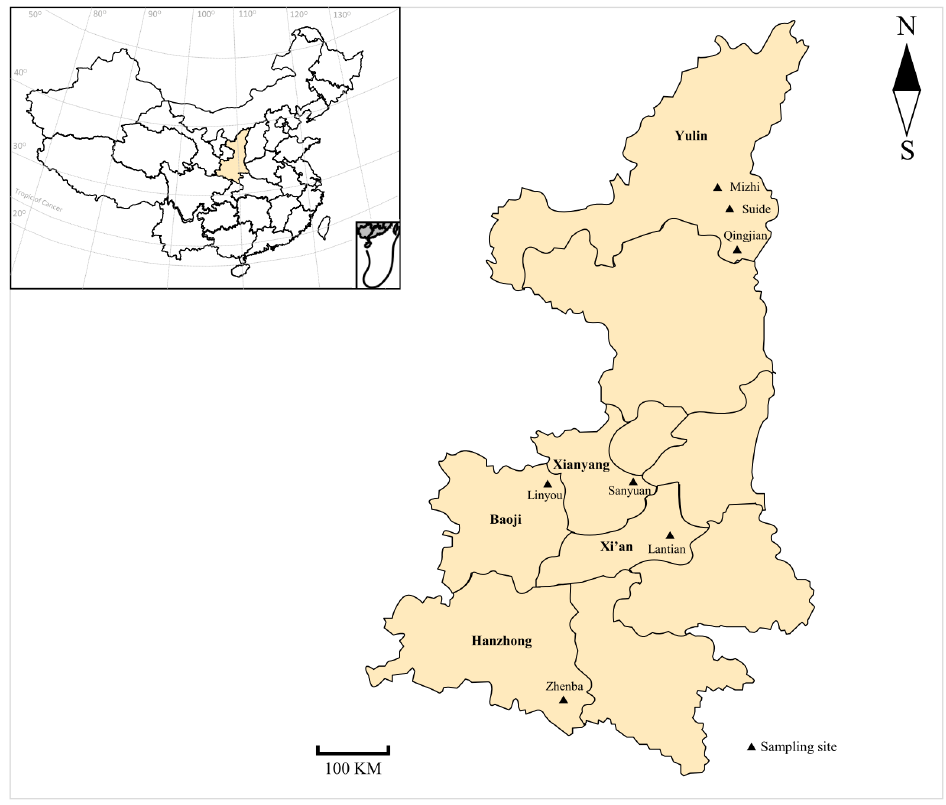
Figure 1. Geographical distribution of sampling sites in Shaanxi province in the present study. Table 1. Information on the samples collected in the present study.